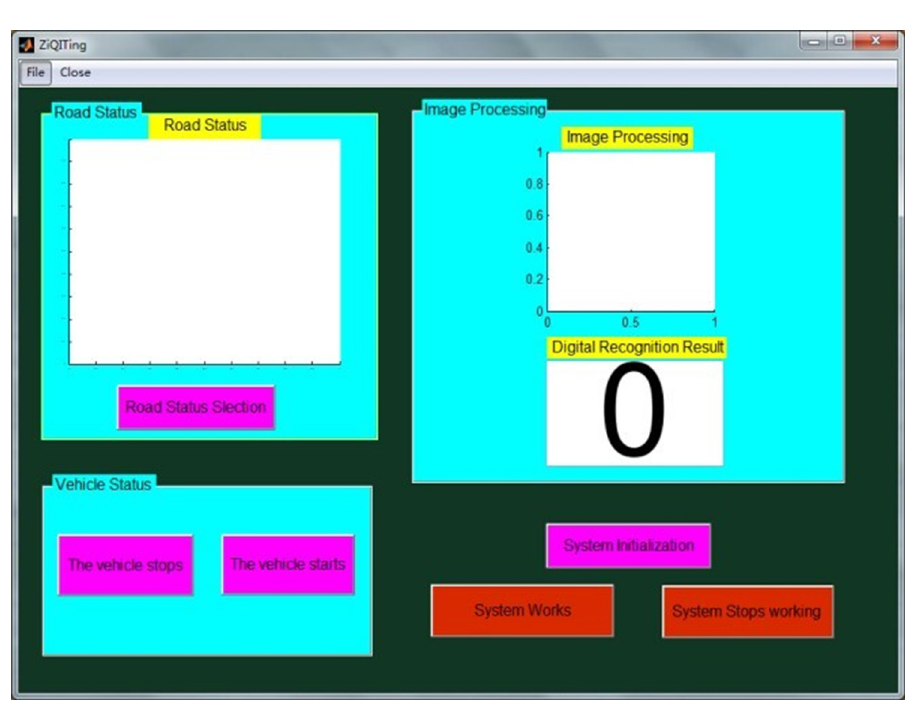
Fig 11. The software interface of